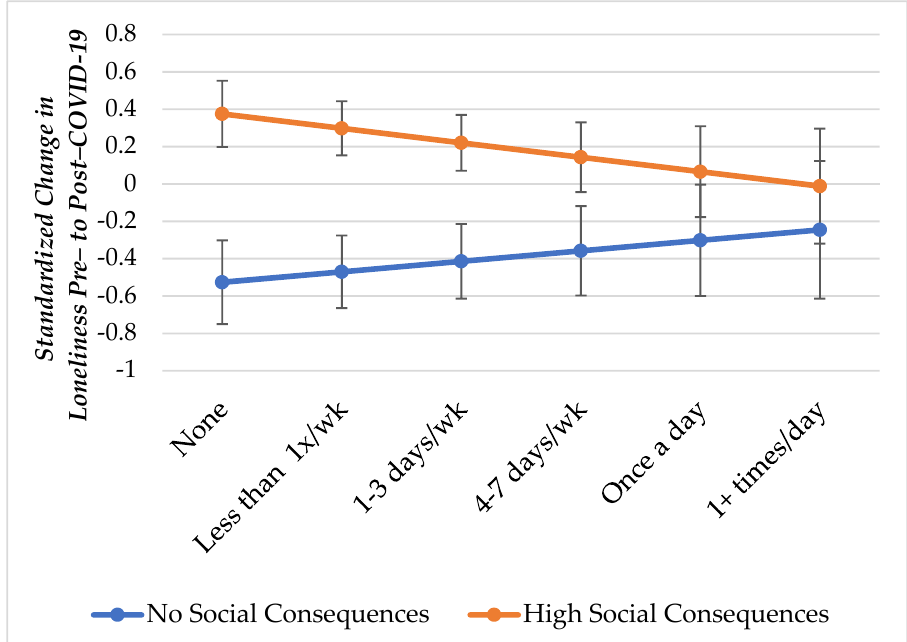
Figure 1. Buffering Effects of Dog Walking on the Social Consequences of COVID-19.